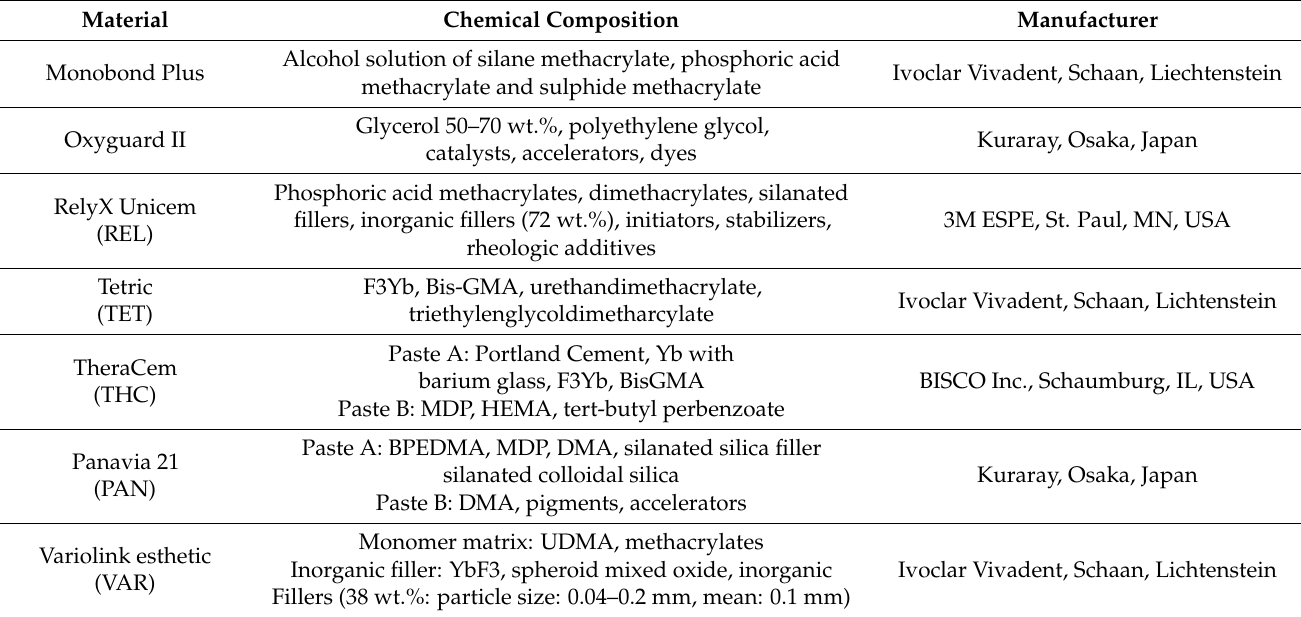
Table 1. The main chemical compositions and brands of the cements and substances used for the experiments. BPEDMA: bisphenol-A-polyethoxy dimethacrylate, DMA: aliphatic dimethacrylate, HEMA: 2-hydroxyethyl methacrylate, MDP: 10-methacryloyloxy-decyl-dihydrogenphosphate, F3Yb: ytterbium trifluoride, UDMA: urethane